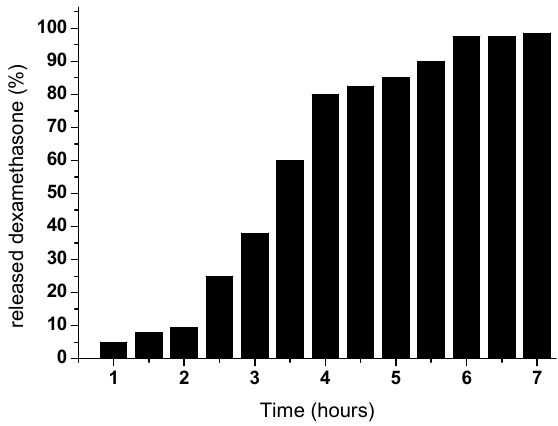
Figure 5. Release behavior of dexamethasone from CS / PVA hydrogel (adapted from [291]).